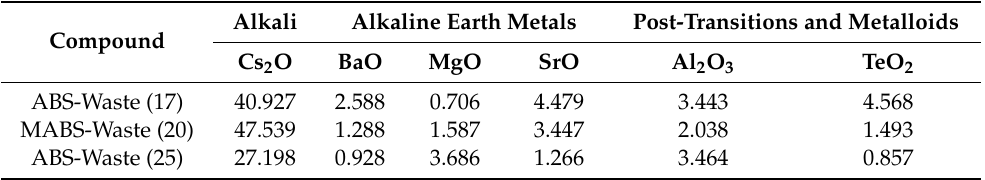
Table 7. Normalized release rate (mg·m −2 ·d −1 ) for waste components: transitions and rare earth elements.